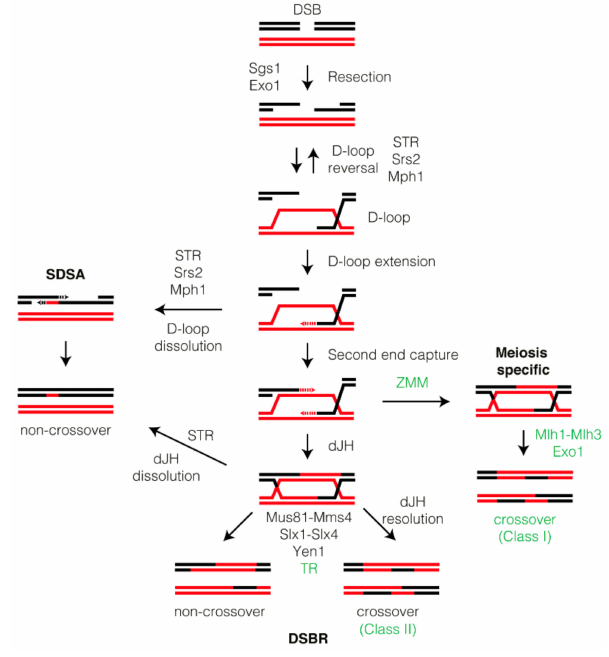
Figure 1. Schematic representation of the role of di ff erent helicases, dissolvases and resolvases in the repair of mitotic / meiotic DNA double-strand breaks (DSBs). The diagram represents some of the more relevant DNA structures generated in response to a DSB during the execution of homologous recombination (HR) and the final outcomes produced after repair. Black lettering represents overlapping roles for a specific complex in both the mitotic and meiotic processing of the DSB. Green lettering represents meiosis-specific features. SDSA: Synthesis-Dependent Strand Annealing, DSBR: Double Strand Break